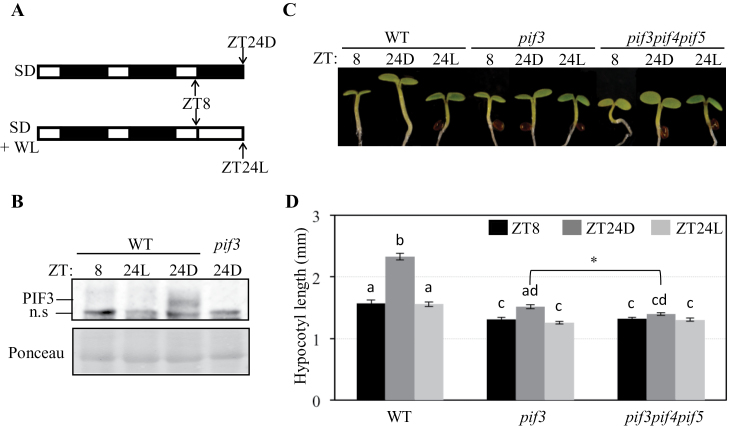
Exposure to WL prevents PIF3 accumulation and growth under SD conditions. (A) Diagram of the growth regime used for B–D. Seedlings were grown under SD conditions for 2 d and 8h, at which time (ZT8) they either were kept under SD and experienced a 16h night (ZT24D), or were moved to WL for the subsequent 16h (ZT24L). (B) Immunoblot of protein extracts from WT seedlings at the specified time points. A PIF3-specific polyclonal antibody was used as probe. As an antibody specificity control, a protein extract from pif3-3 harvested at ZT24D was included. Ponceau staining was used as a loading control (bottom). n.s., non-speciﬁc cross-reacting bands. (C) Visual phenotype of WT, pif3, and pif3pif4pif5 seedlings grown as detailed in A. (D) Hypocotyl length in WT, pif3, and pif3pif4pif5 seedlings grown as detailed in A. Data represent the mean and SE of at least 20 seedlings. Different letters denote statistically significant differences among means defined by Tukey-b’s multiple comparison test (P < 0.05). Comparison between pif3 and pif3pif4pif5 genotypes in short-day conditions (ZT24D) fell short of statistical significance under the stringent Tukey-b statistical test but showed a statistically significant difference (P <0.05) by Student’s t-test (indicated with an asterisk). (This figure is available in colour at JXB online.)